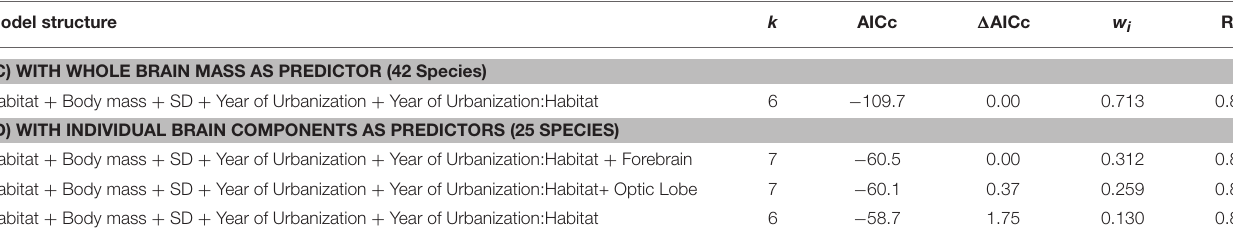
TABLE 3 | The best-ranked PGLS regression models (models with 1 AICc < 2) predicting FID across bird species (including rural and urban populations of those species). Model structure k AICc 1 AICc w i R